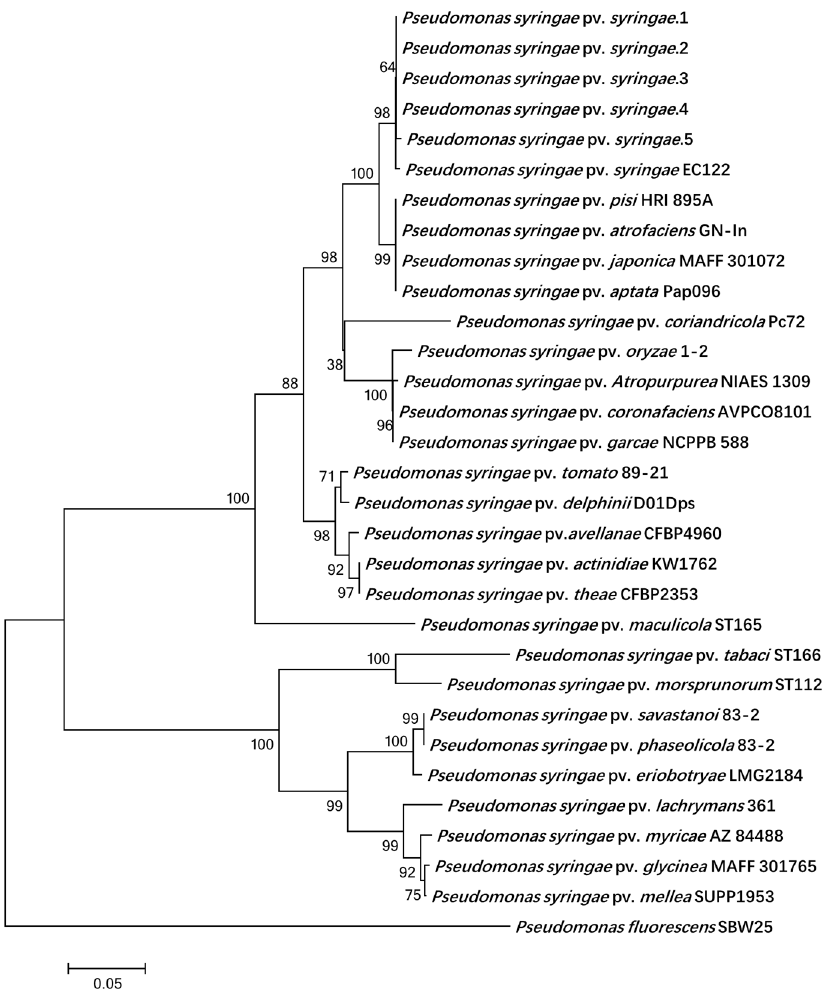
Figure 3. Neighbor-joining phylogenetic tree of P. s. pv. syringae strains from rice and reference strains derived from a concatenation of gyrB - rpoD - gltA genes. Bar—estimated nucleotide substitutions per site is 0.05.